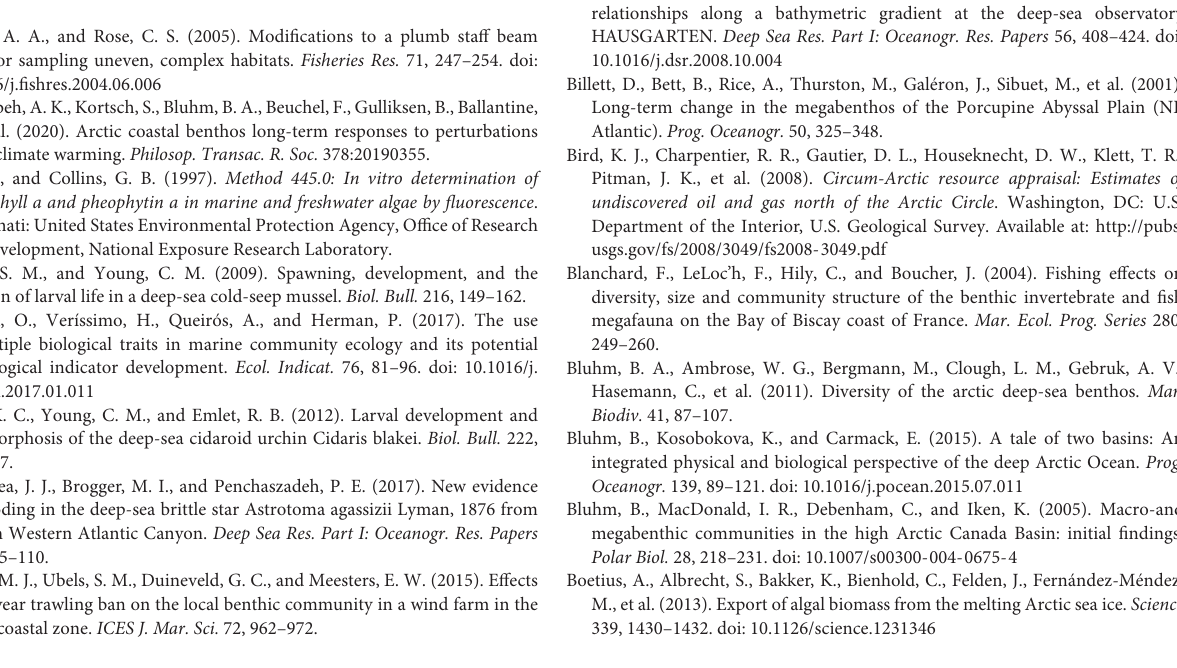
Supplementary Figure 1 | Schematic representation of the hypotheses, methods used to test the hypotheses and number of figures/tables representing results. Trait modality codes are abbreviated by two letter-one number combinations and explained in Table 2 . Supplementary Figure 2 | Results of the fuzzy correspondence analysis on the biological traits of epifauna from the Chukchi Borderland weighted by taxa proportional abundances from trawl samples, (A) ordination by stations, where numbers are station numbers, (B) ordination by traits, where trait modality codes are abbreviated by two letter-one number combinations and explained in Table 2 . Red – mid-depth stations. Blue – deep stations. Supplementary Figure 3 | Boxplots comparing modalities of different traits (weighted by proportional abundance) for mid-depth (in red) and the single deep station (grey line) based on trawl samples of epifauna from the Chukchi Borderland; (A) body form, (B) feeding habit, (C) reproduction, (D) living habit, and (E) adult movement. Note traits contributing most to variability among stations based on the Fuzzy Correspondence Analysis results are shown; modalities of these traits with low proportional abundance are not shown. Asterisks indicate significant difference between mid-depth and deep stations ( p < 0.05, Kruskal–Wallis test). Trait modalities are defined in Table 2 . Supplementary Figure 4 | Boxplot of functional diversity indices for epifauna from the Chukchi Borderland, (A) Functional Diversity (FD) (represented by Rao’s Q) and (B) Functional Redundancy (FR) for mid-depth (red) and deep trawl samples of epifauna from the Chukchi Borderland. Note the scales of the y -axes are different. Supplementary Figure 5 | Results of canonical correspondence analysis performed on the traits by stations matrix for trawl data of the epifauna from the Chukchi Borderland. Traits identified as most important in the FCA analysis are presented; (A) body form, (B) reproduction, (C) living habit, (D) adult movement, (E) feeding habit, and (F) substrate affinity. Passive environmental factors are overlain on the figure panels in gray color; environmental factors in red are those that were used to constrain the CCA. Mid-depth stations are present in red triangles and deep station is present in blue circles. Station numbers are identified in green on the last CCA plot. Trait modality codes are abbreviated by two letter-one number combinations and explained in Table 2 .